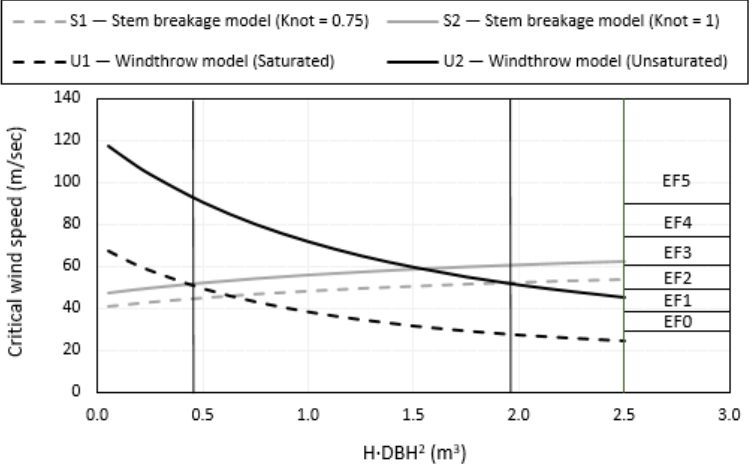
Figure 8. Relationships between critical wind speed and H·DBH 2 for uprooted and stem broken